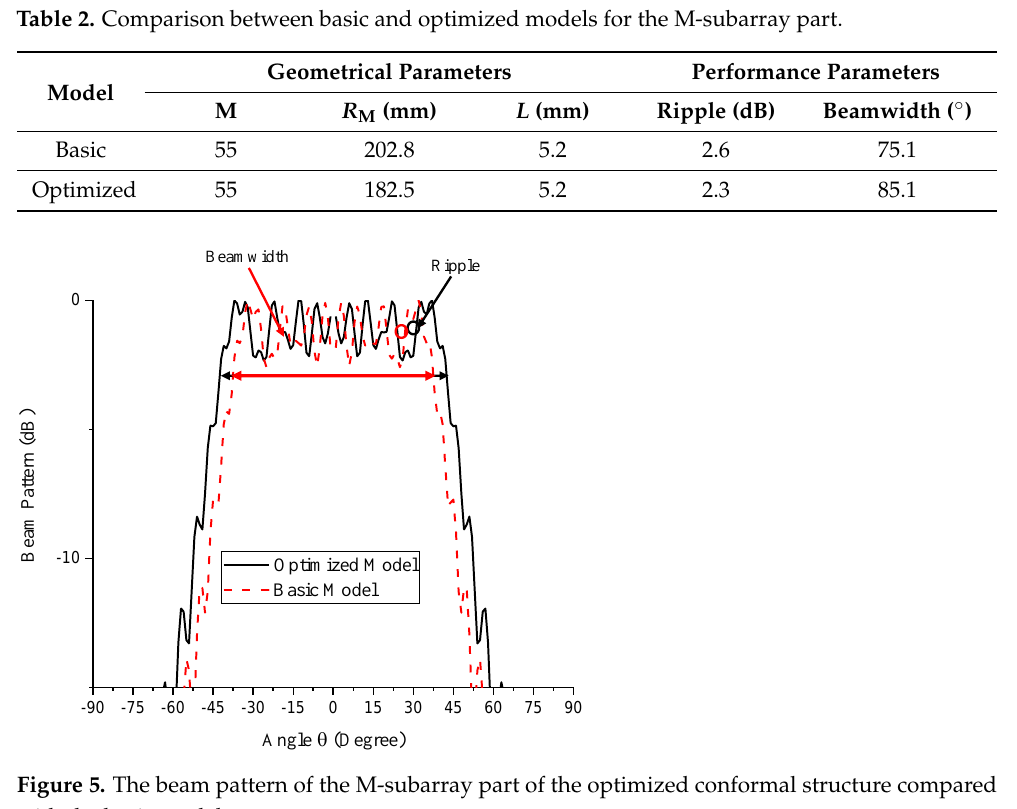
Table 3. Variation range of design variables for the N-subarray part.